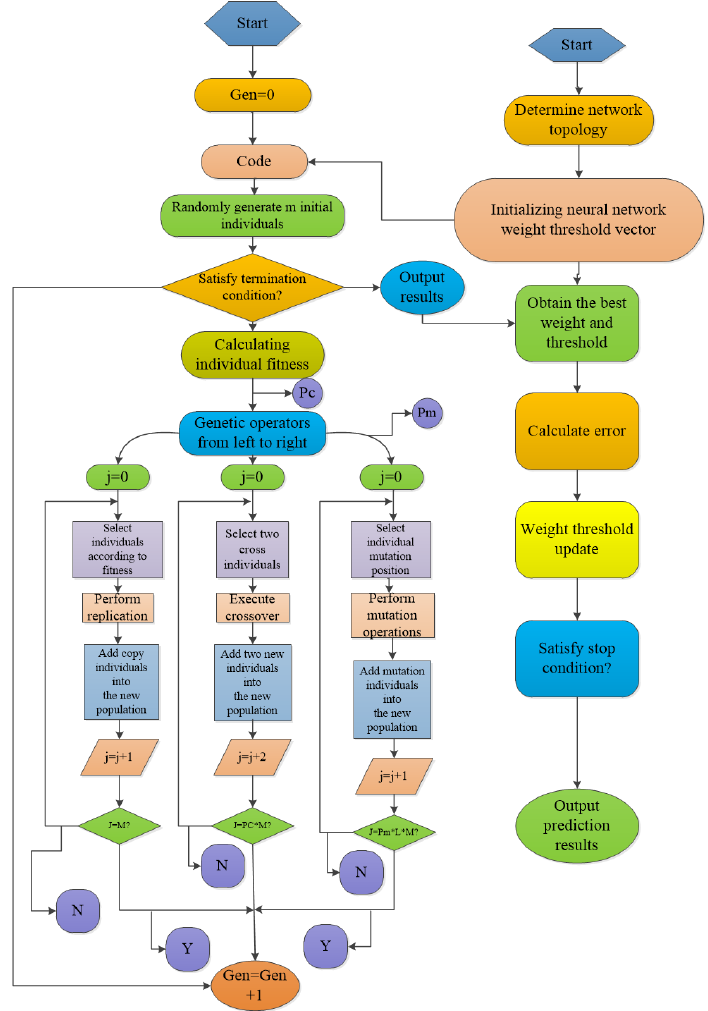
Figure 4. The flow chart of GA optimization process. Particle swarm optimization (PSO) algorithm is a search algorithm proposed by Kennedy and Eberhart to simulate the social behavior of birds in the bird swarm. It finds the optimal solution by “flying” individuals called particles in the super dimensional search space. Each particle will adjust its trajectory according to its best position (local optimum) and the best particle (global optimum) in the whole population, which increases the randomness of particles and quickly converges to a reasonable global minimum of the rational solution [43]. The flow chart of PSO is shown in Figure